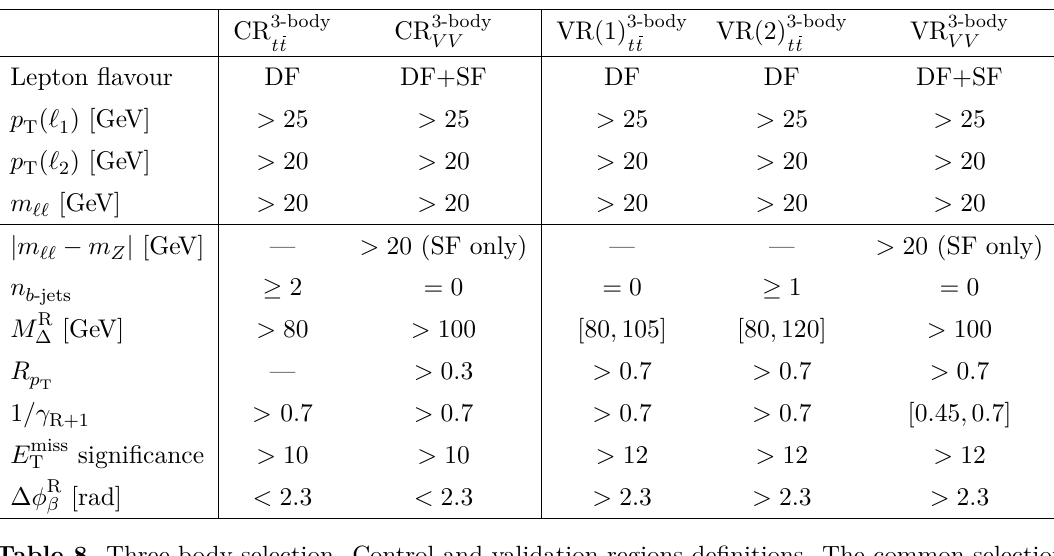
was defined previously tt Z